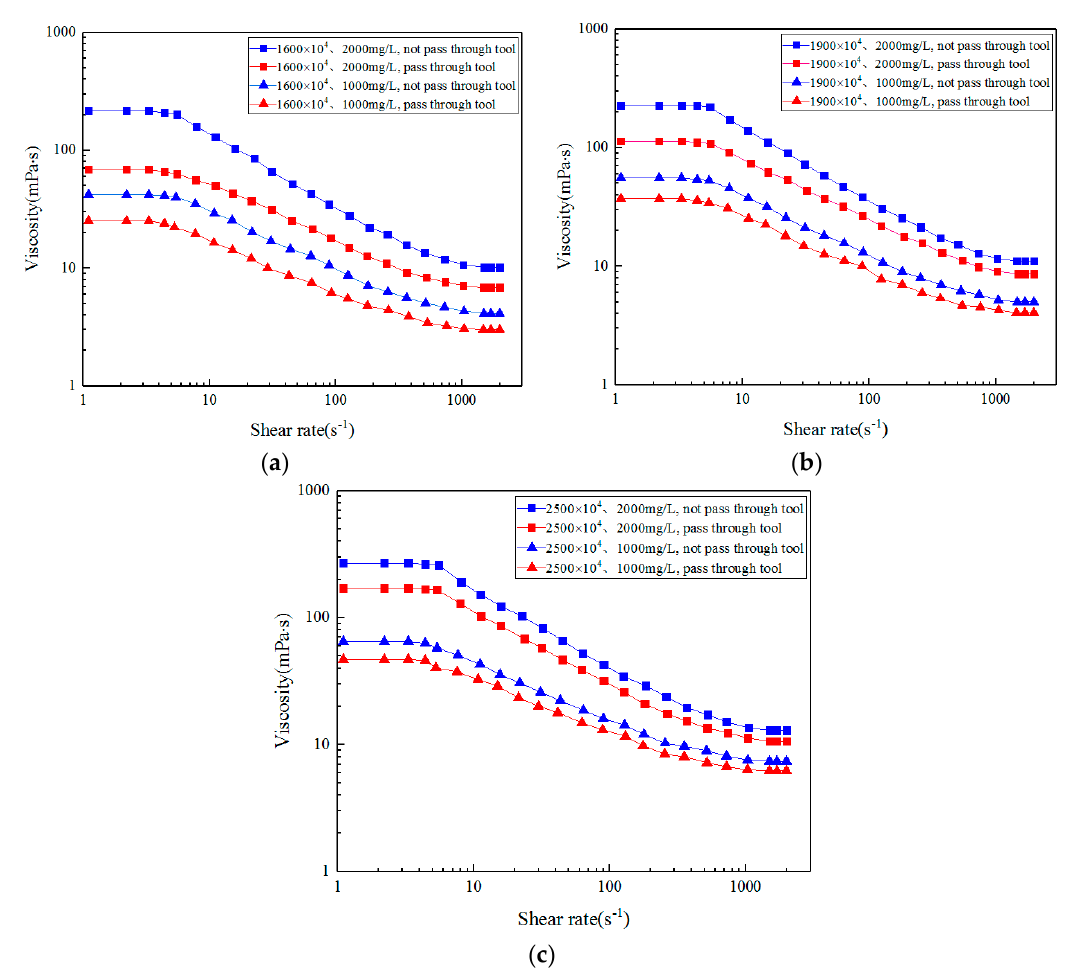
Figure 6. Variation of viscosity with shear rate of ASP solution before and after flowing through the different medium tool: ( a ) 16 million (MD); ( b ) 19 million (MD); ( c ) 25 million (MD).